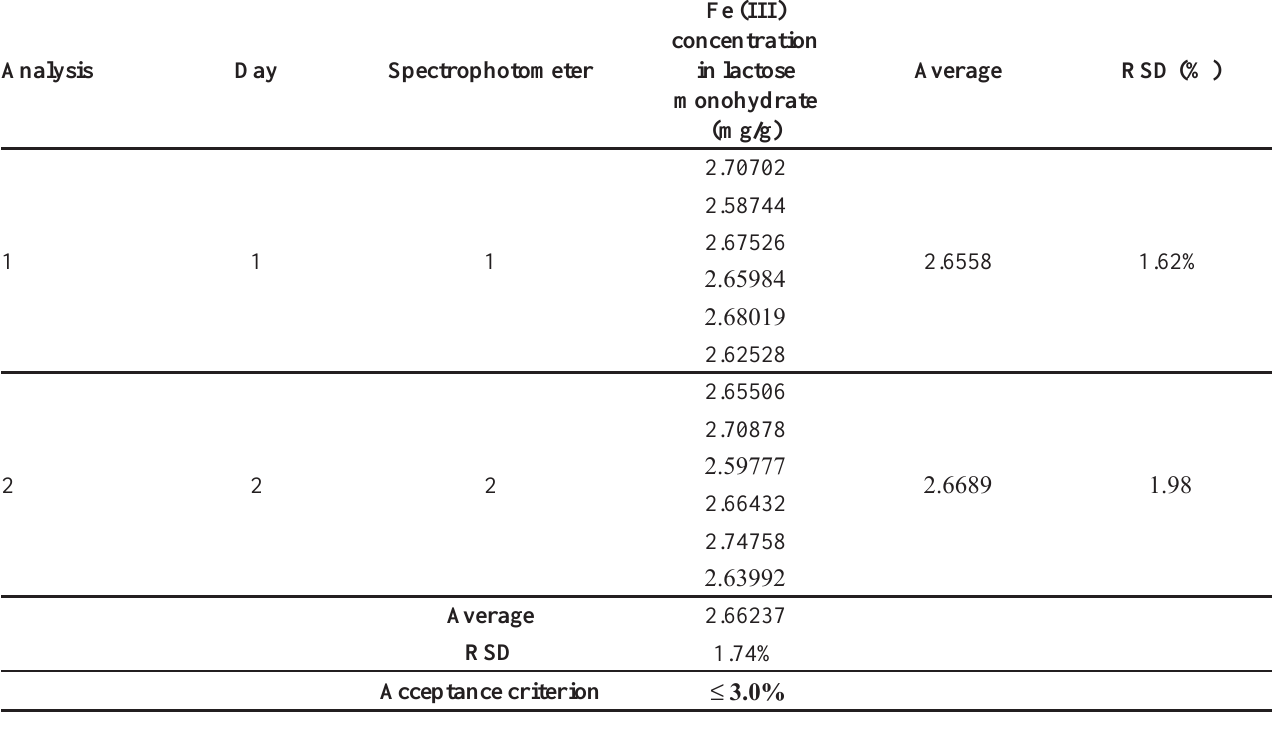
TABLE VI - Results of the intermediate precision